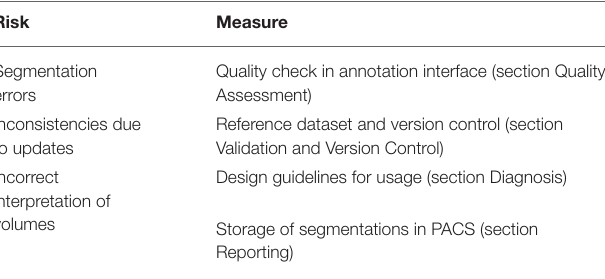
TABLE 1 | Overview of identified risks and measures to address those risks. Risk Segmentation